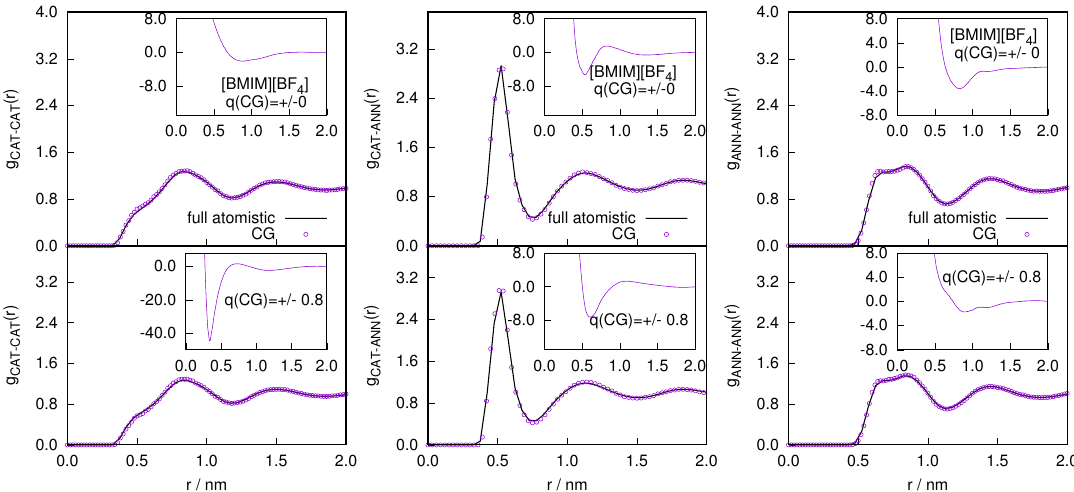
Figure 9. The radial distribution function obtained from reference atomistic and coarse-grained simulation with charged ( bottom ) and neutral model ( top ) as a function of distance r for the [ BMIM ][ BF ] − . The CG simulation employs the IBI potential, V 4 and neutral CG models.